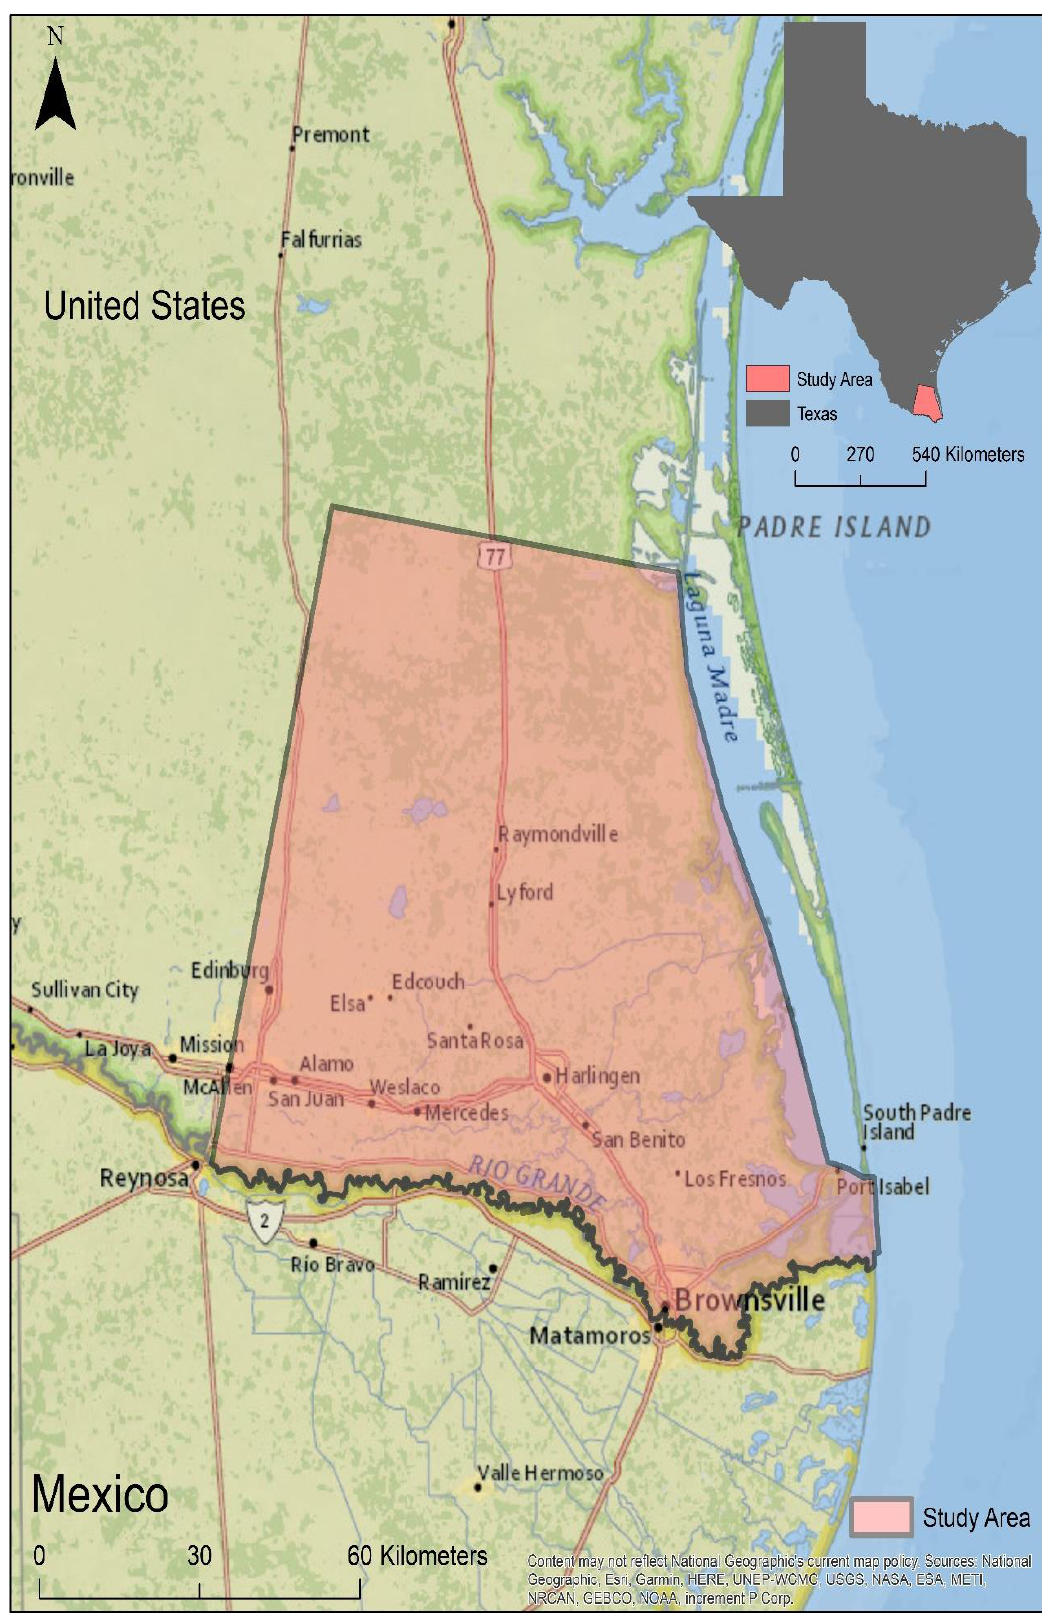
Figure 1. Rio Grande Delta and surrounding rangeland study area in southeastern Brooks, Kenedy, Willacy, Cameron, and eastern Hidalgo counties, South Texas, USA (10,065 km 2 ).